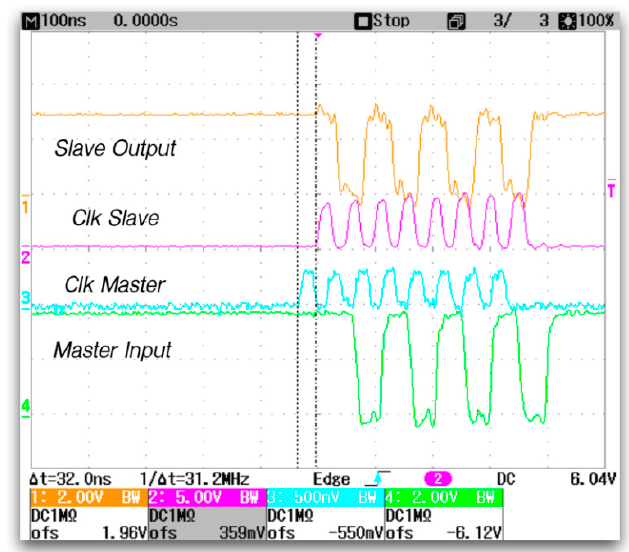
Figure 9. Screenshot taken from a LeCroy WaveJet 324 oscilloscope. The orange signal is the slave output, the purple one is the clock received by the slave, the blue one is the clock sent by the master, and the green one is the slave signal received by the master.